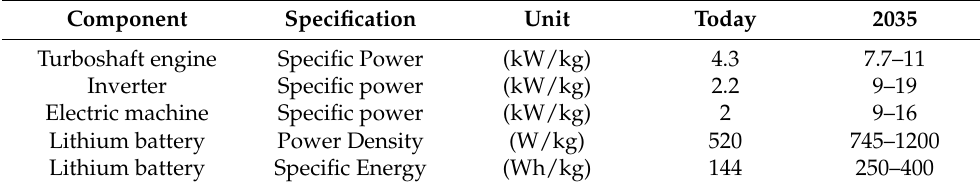
Table 1. Current and future values of specific power and energy densities